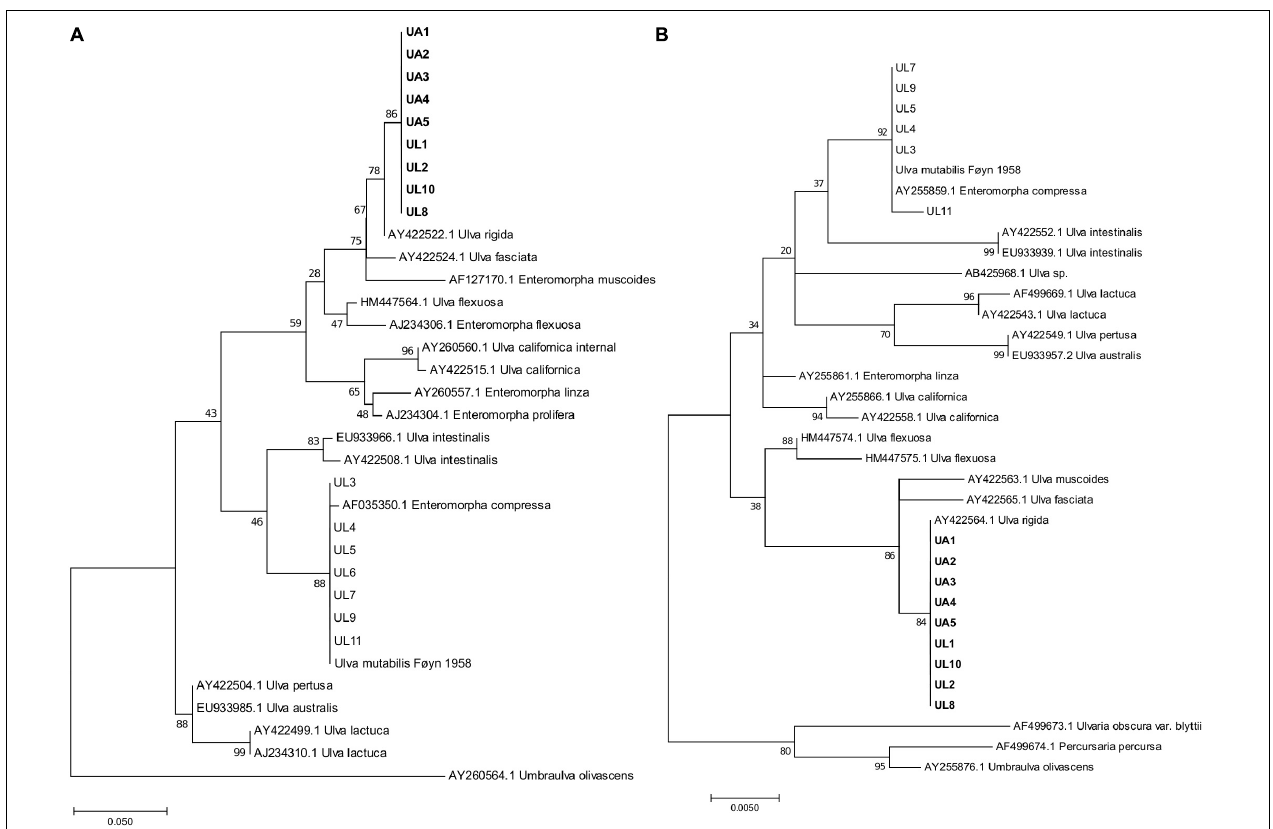
FIGURE 2 | Maximum-likelihood phylogenetic trees of ITS (A) and rbcL (B) DNA fragments. The trees are drawn to each independent scale, with branch lengths measured in the number of substitutions per site; the numbers at nodes refer to bootstrap values (1000 replication). For the ITS fragments tree (A) the analysis involved 34 sequences and 283 nucleotides positions. For the rbcL fragments tree (B) the analysis involved 35 sequences and 478 nucleotide positions. UL, Ulva specimens analyzed in this study from coastal lagoon; UA, Ulva specimens analyzed in this study from aquaculture tanks. Type strain “ Ulva mutabilis (Føyn)” is still available in culture. Strains in bold were selected for microbiome analysis. The original names in the database were